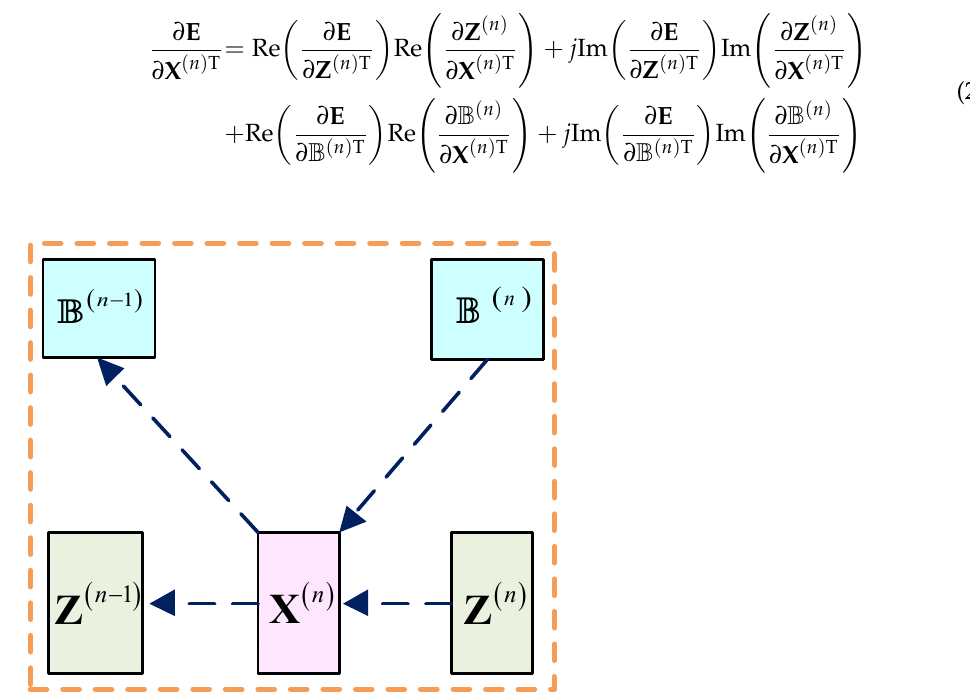
Figure 5. Back-propagation of the reconstruction Figure 5. Back ‐ propagation of the reconstruction layer.